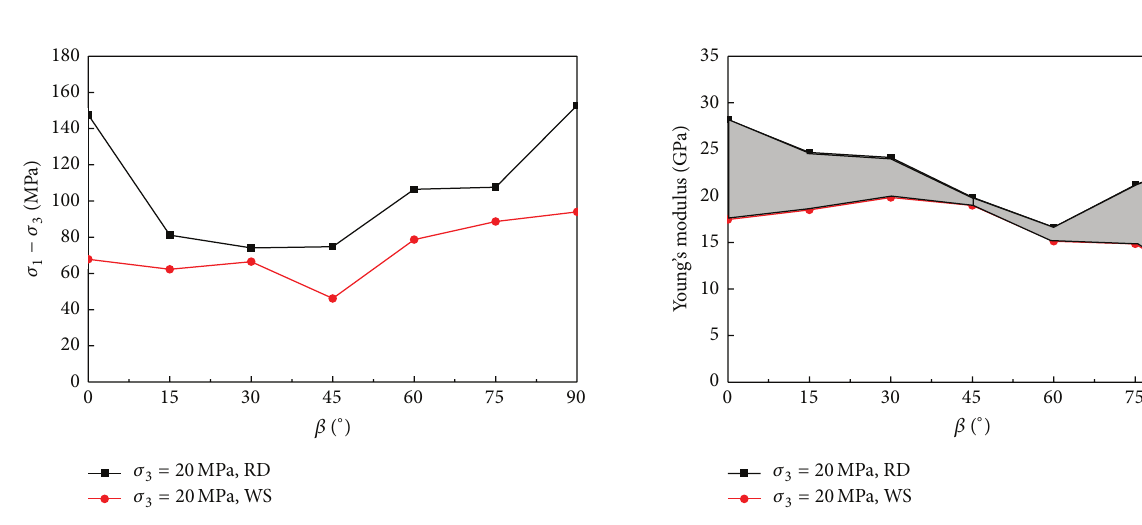
Figure 13: Comparison of the tangent Young modulus of the room dried and saturated